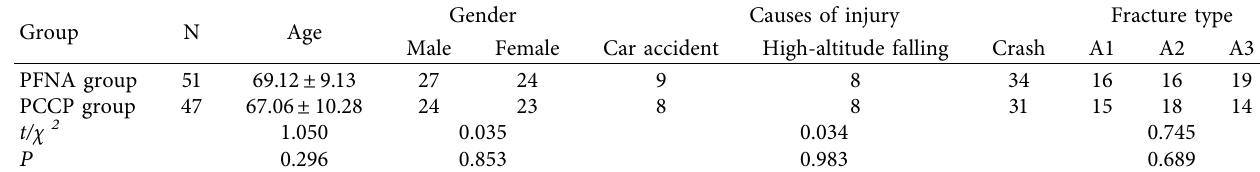
Table 1: Comparison of general data between the two